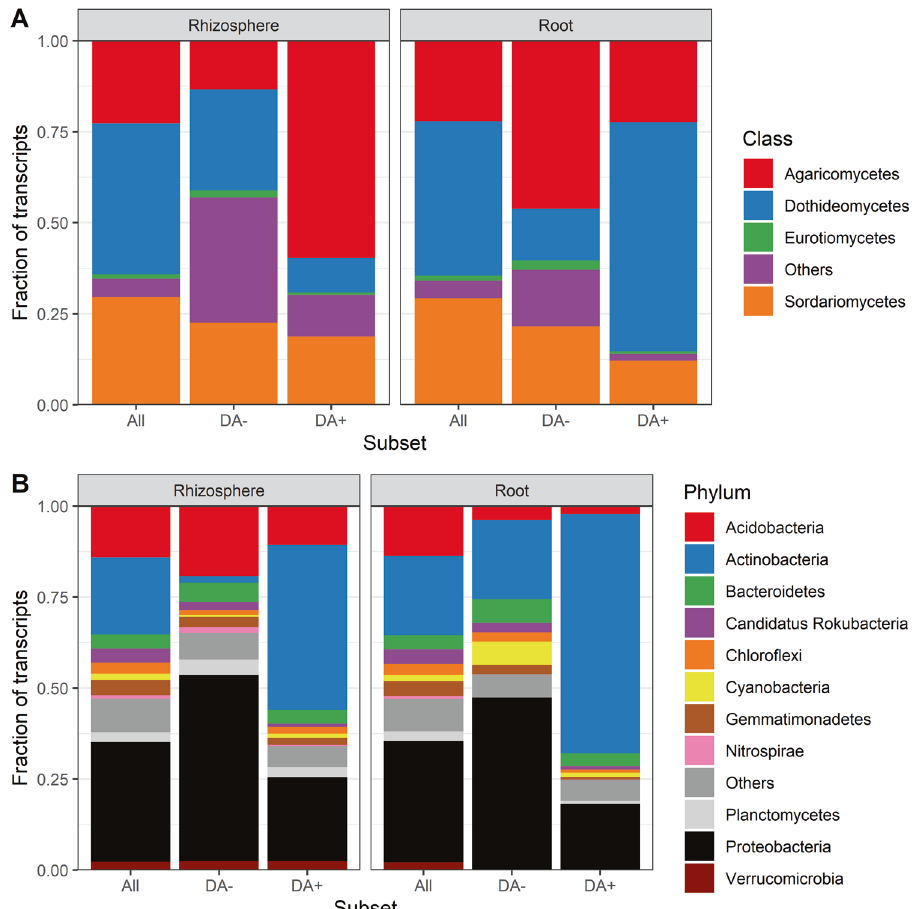
Fig. 3 Phylum- and class-level af fi liations of transcripts. Stack bar chart comparing the taxonomical af fi liations of transcripts associated to ( A ) fungi and to ( B ) bacteria in the roots and the rhizosphere across all samples vs. among transcripts positively (DA + ) or negatively (DA-) differentially abundant. The transcripts not classi fi ed at this level ( “ NULL ” ) were